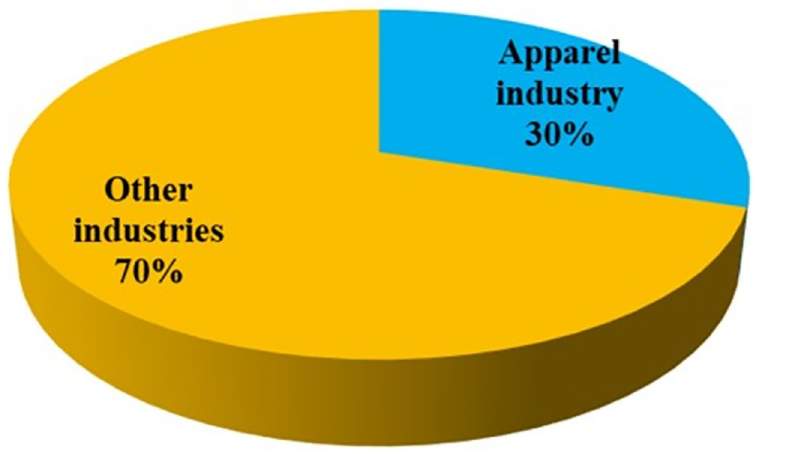
Fig 1. Approximate energy consumption scenario by industries in Bangladesh